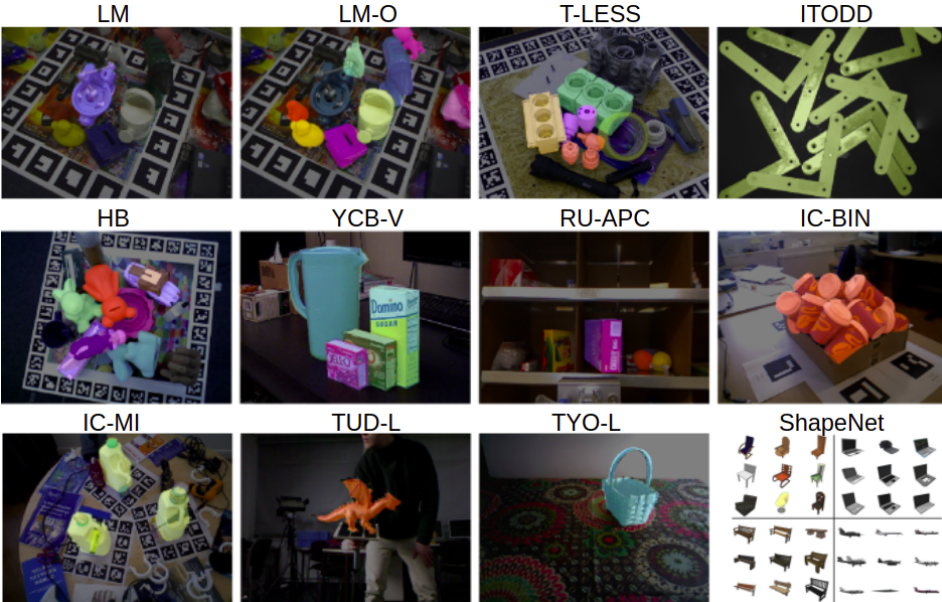
Figure 3. Benchmark datasets widely used for object detection and 6D pose estimation: LM [27], LM- O [28], T-LESS [33], ITODD [34], HB [29], YCB-V [32], RU-APC [30], IC-Bin the Ref. [35], IC-MI [31], TUD-L and TYO-L [38] and ShapeNet